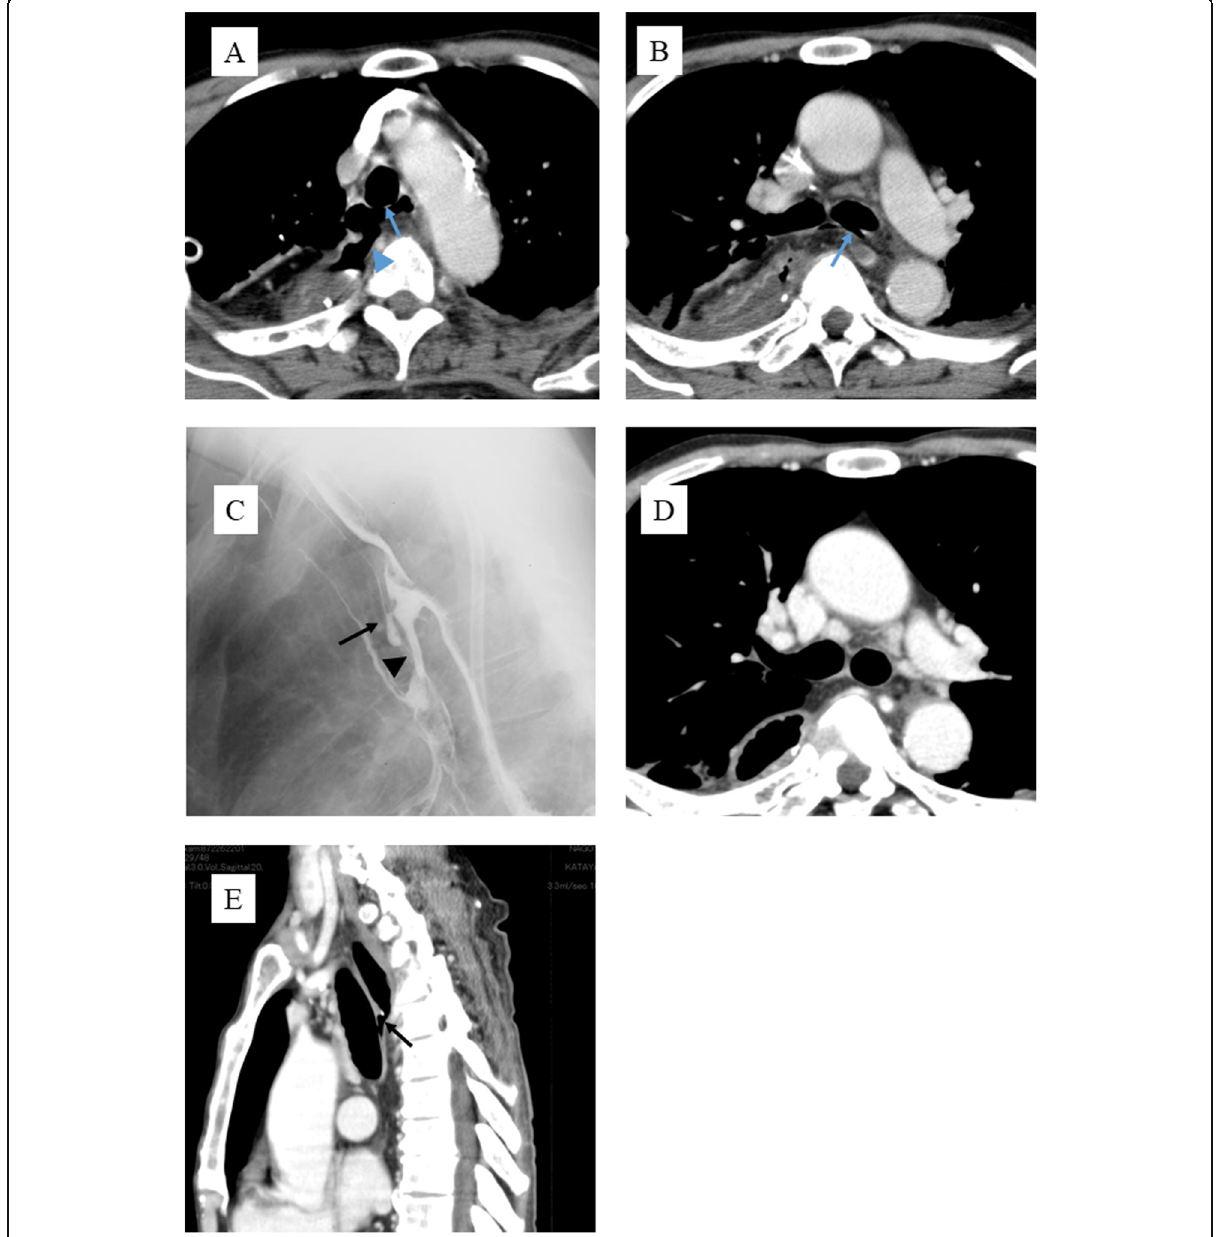
Fig. 1 On postoperative day 7, computed tomography (CT) revealed anastomotic leakage (blue arrowhead) and a tracheal fistula (blue arrow) ( a ). On postoperative day 7, a left main bronchial fistula was observed (blue arrow) ( b ). On postoperative day 49, an upper gastrointestinal series showed a fistula within the trachea (black arrow) and a fistula within the left main bronchus (black arrowhead) ( c ). CT (postoperative day 117) revealed that the left main bronchial fistula was closed by covering it with omentum ( d ), and the GTF was open (black arrow) ( e